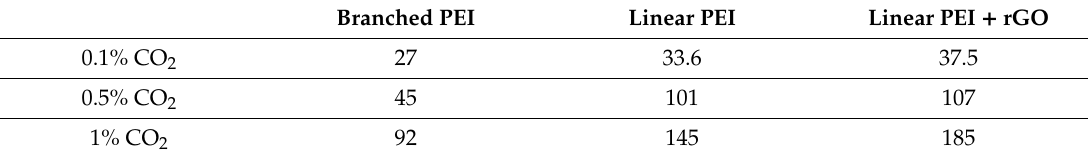
Table 1. Frequency shift (in Hz) of each coating at di ff erent concentration of CO 2 .